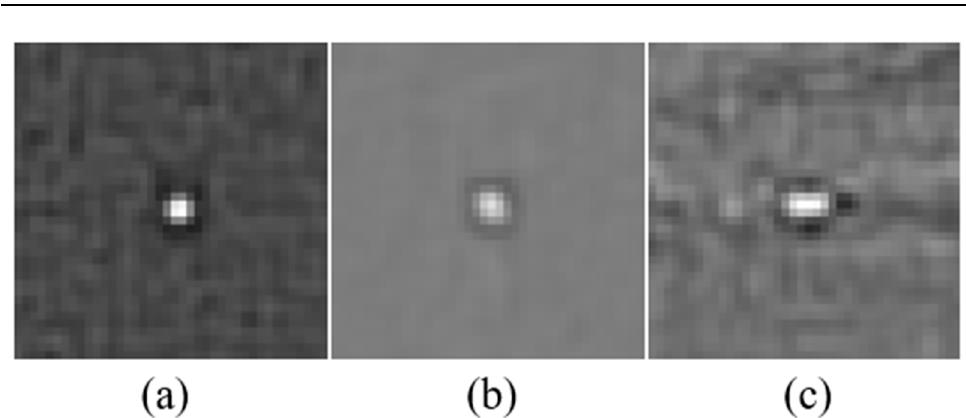
Figure 3. The filtering results of the targets in the Figure 2. Algorithm 1. Pseudocode for Binarized Mask Calculation